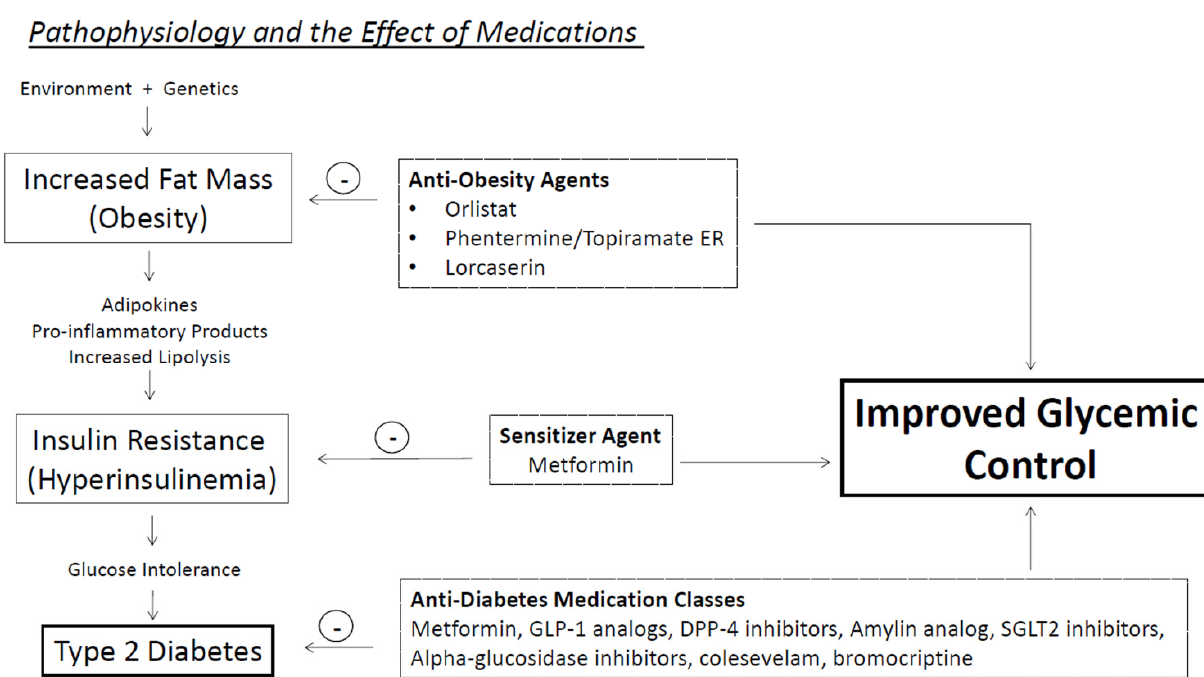
Figure 1. Pathophysiology and the Effect of